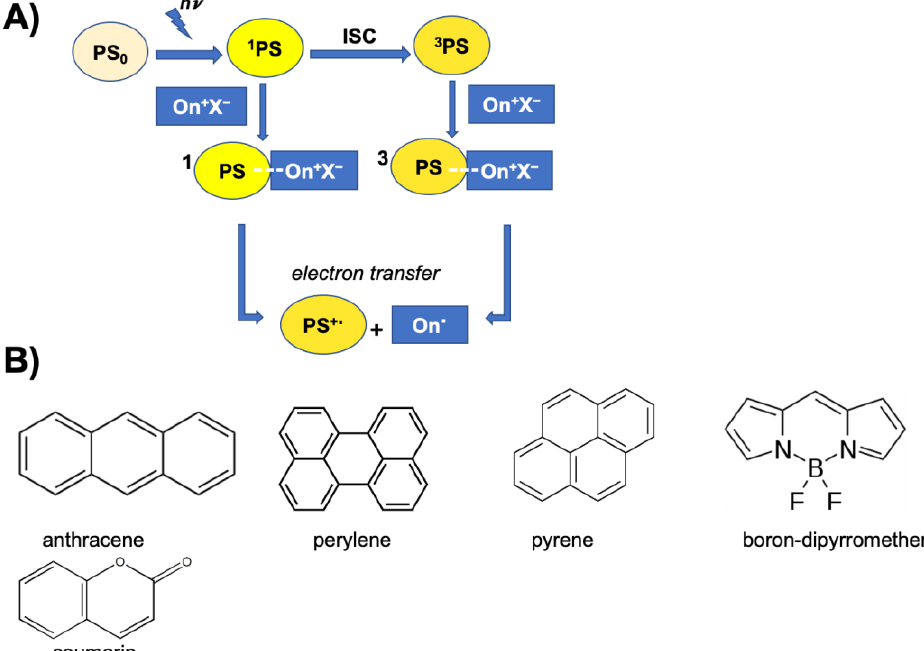
Figure 5. ( A ) Schematic representation of the onium salt photosensitization process by electron transfer. ( B ) Polycyclic aromatic compounds most commonly used as photosensitizers: anthracene, perylene, pyrene, boron-dipyrromethenes, coumarin. 1 PS photosensitizer in a singlet or 3 PS triplet (cid:48) state, On ٠ radical onium salt.